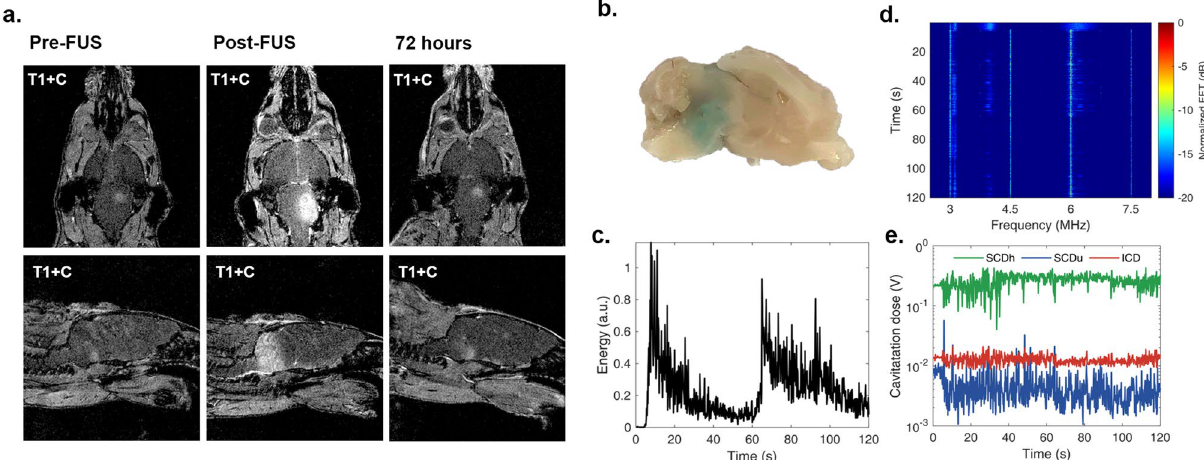
Figure 2. BBB opening and recorded acoustic emissions with passive cavitation measurements. ( a ) T1-weighted MR imaging showing sonication of tumor and peritumoral region. BBB closure demonstrated at 72 h after FUS. ( b ) Evans blue staining demonstrates BBB disruption on gross histology. ( c ) In vivo passive cavitation detection measurements confirmed that stable cavitation dominated throughout ultrasound treatment. Acoustic energy emitted by the microbubbles was higher in the beginning of the treatment, and gradually decreased due to microbubble clearance from the vasculature. ( d ) Spectrogram of the entire treatment session. Higher harmonic emissions were detected, with no substantial increase in the broadband floor after microbubble entrance into the focal volume. ( e ) Stable harmonic cavitation levels rose slightly after microbubble Fourier